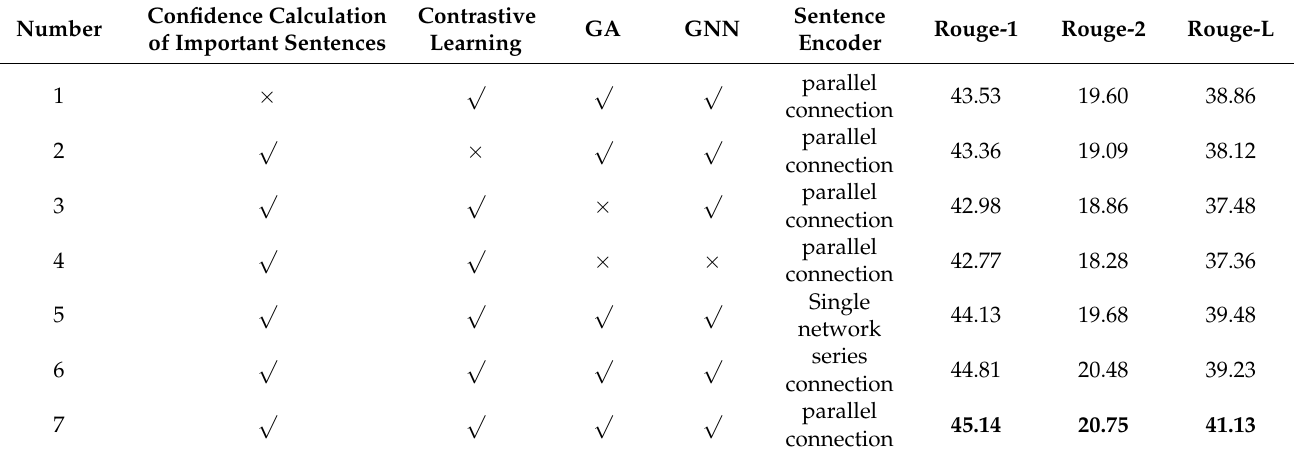
Table 1. Ablation